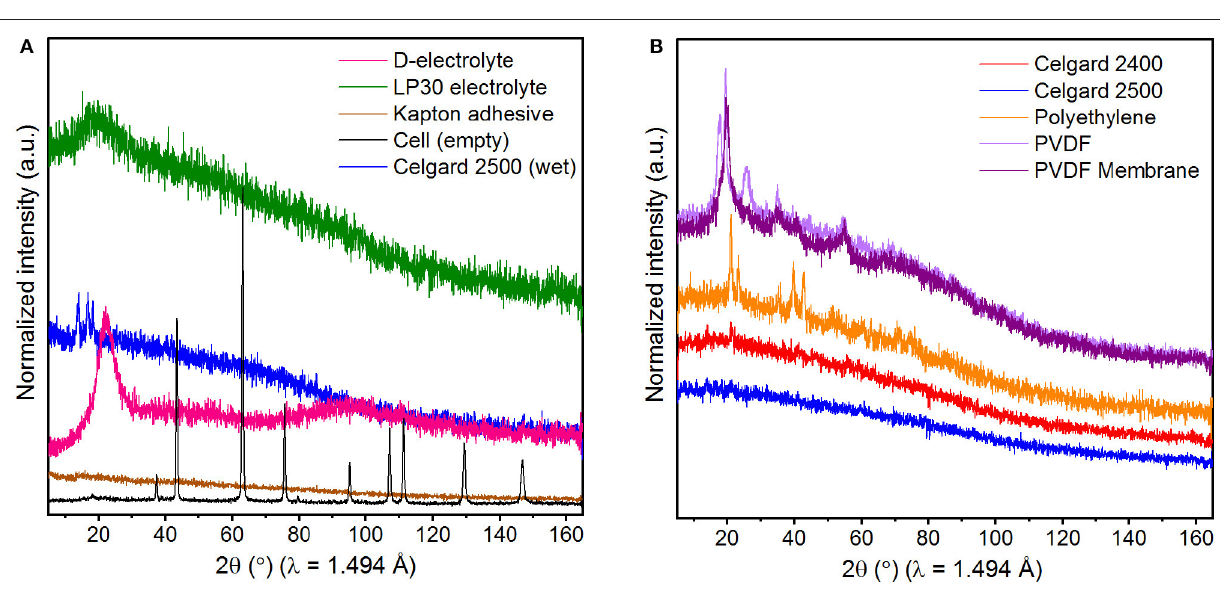
vs. Li + /Li during charging is presented as an example in Figure 5A . The achieved signal-to-noise ratio is sufficient to allow the diffraction peaks of the layered material to stand